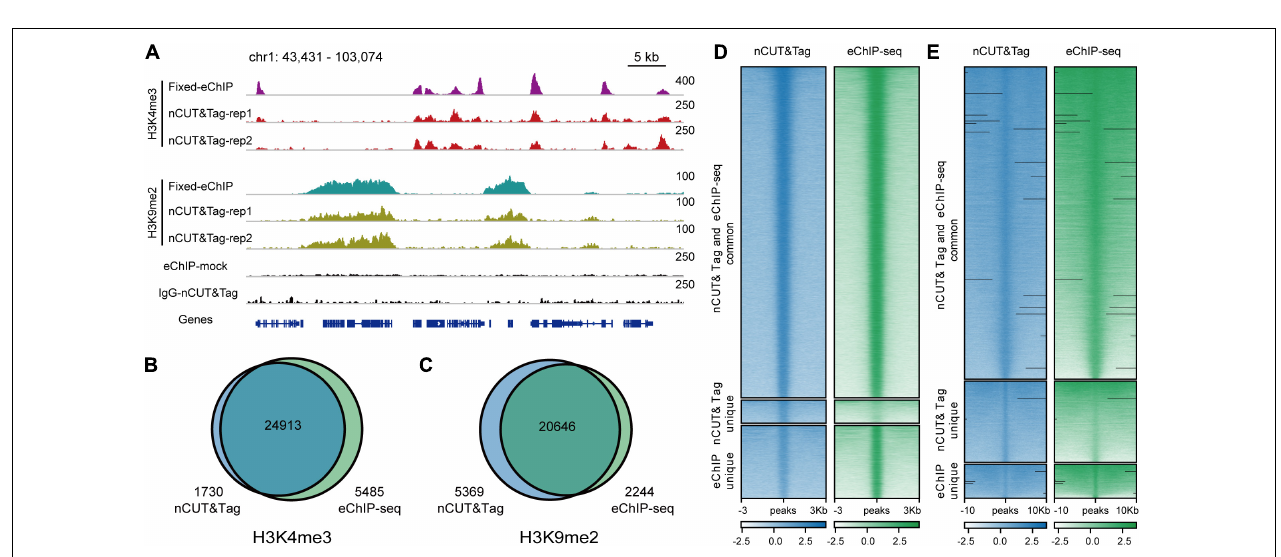
FIGURE 3 | nCUT&Tag for fast chromatin profiling with crosslinked tissue. (A) Representative H3K4me3 landscapes across chr1:5,374,839–5,558,400 of the rice genome generated by eChIP-seq and nCUT&Tag. The green and blue boxes show peaks detected only by eChIP-seq and nCUT&Tag, respectively. (B) Scatter plots showing the Spearman’s correlations for the two H3K4me3 nCUT&Tag replicates (left), and between the nCUT&Tag and eChIP-seq data (right). (C) Venn diagram showing the overlap of H3K4me3 peaks detected by eChIP-seq and nCUT&Tag. (D) Comparison of the H3K4me3 eChIP-seq and nCUT&Tag signals.